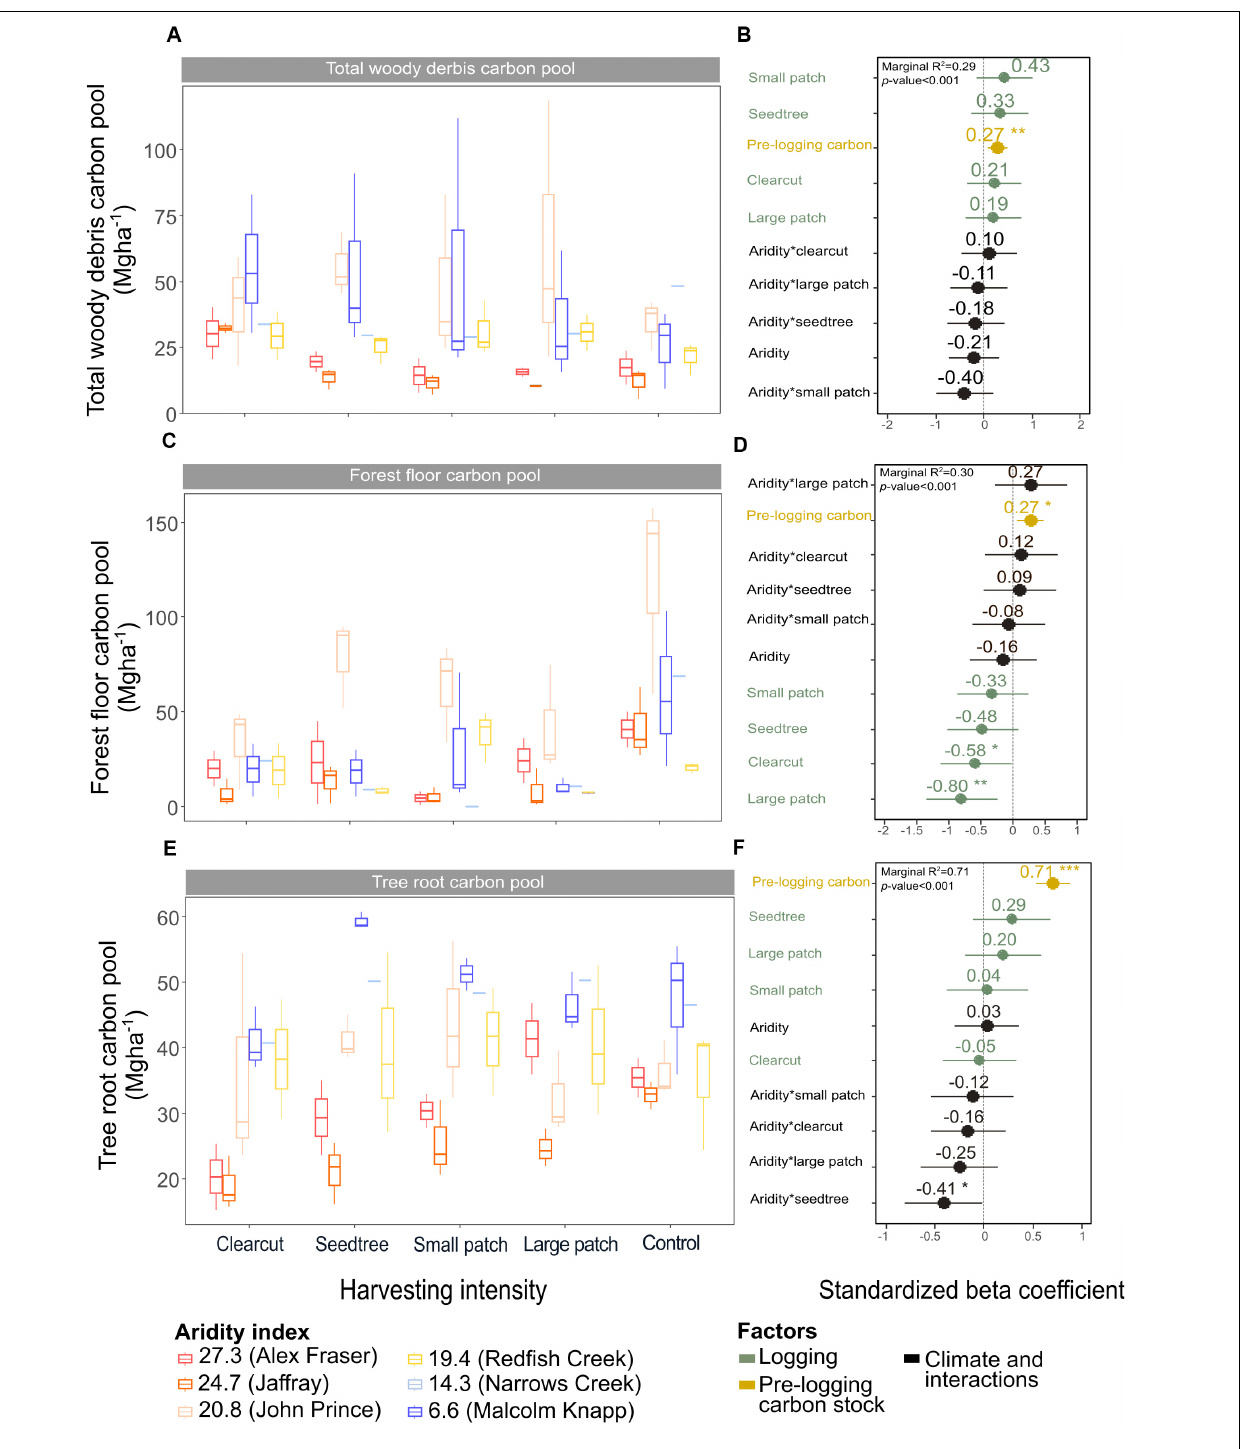
FIGURE 5 | Effect of harvesting intensity and climatic aridity on carbon pools in total woody debris (A,B) , forest floor (C,D) , and tree roots (E,F) of mixed Douglas-fir forests ( n = 3 for all locations, except Narrows Creek where n = 1 and Alex Fraser where n = 2). (B,D,F) present standardized beta coefficients of linear mixed-effect models. Beta coefficients illustrate the effect of factors on total woody debris (B) , the forest floor (D) , and tree roots (F) in terms of their standardized effect sizes. Circles indicate average estimates and lines indicate 95% confidence intervals. The aridity index was calculated as [mean annual temperature + 10]/mean annual precipitation/1000]. For harvesting intensity, each coefficient represents the difference between the uncut control and a given treatment. *** P -value < 0.001; ** P -value < 0.01; * P -value < 0.05.